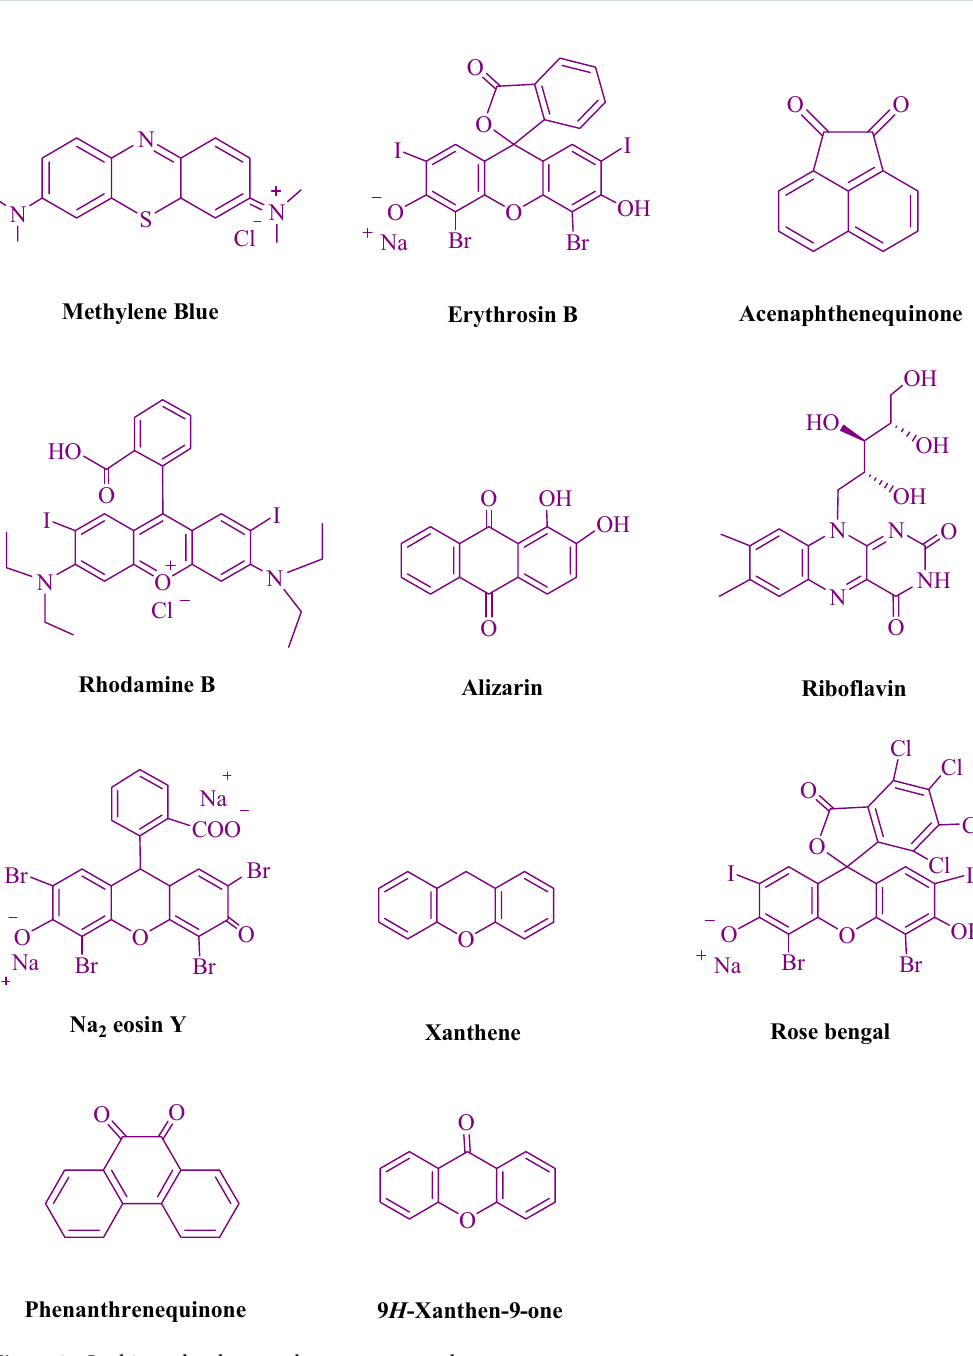
Figure 2. In this study, photocatalysts were put to the